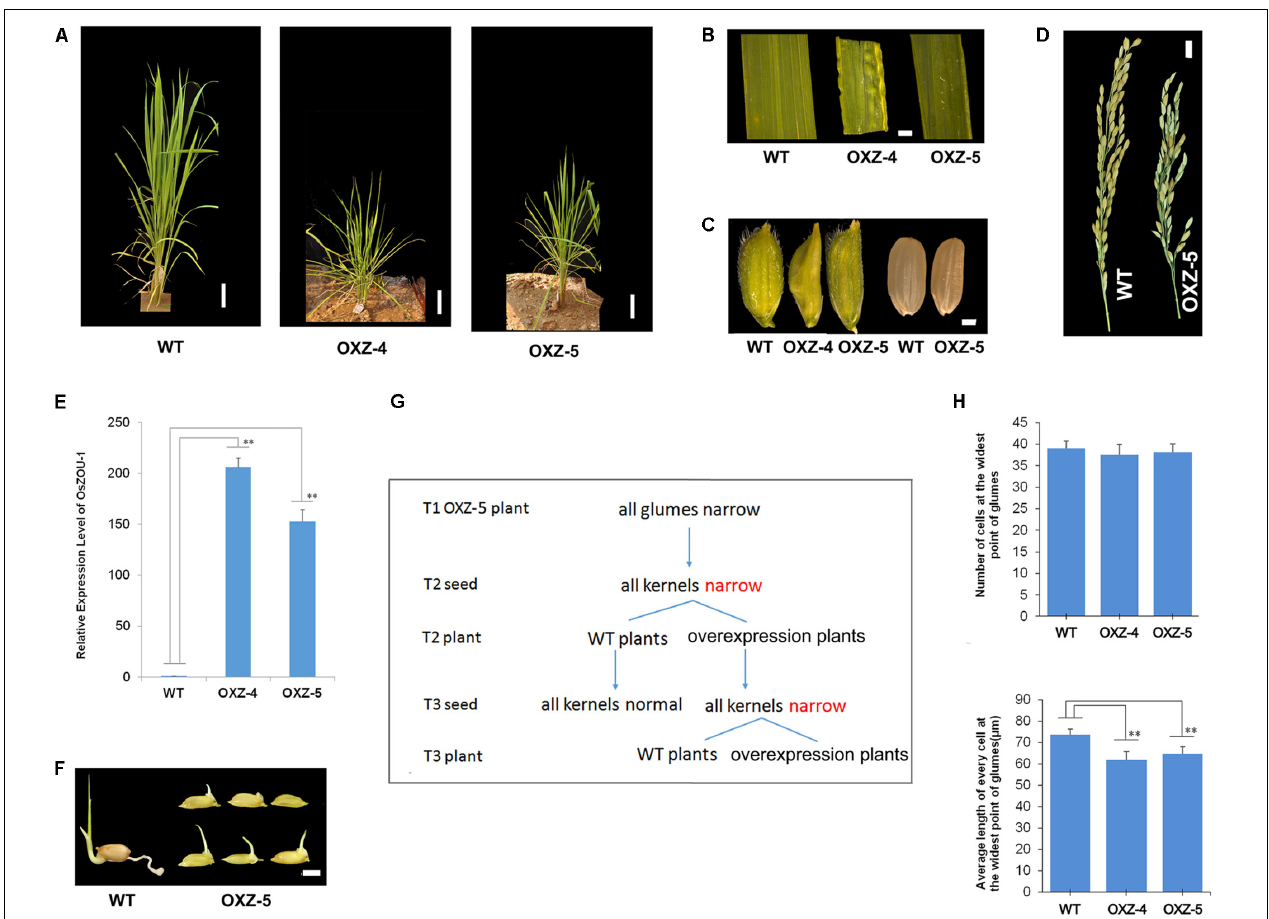
FIGURE 6 | The phenotype of OsZOU-1 over-expression lines. (A) The morphology of WT and OsZOU-1 over-expressed plants OXZ-5 and OXZ-4 in the jointing-booting stage were photographed. Scale bars = 8 cm. The OXZ-5 plant (54.48 cm) and OXZ-4 plant (47.52 cm) were shorter than the WT plant (81.28 cm). (B) The leaves of OXZ-5 and OXZ-4 curled upward along the leaf margin before booting and were narrow, while some leaves of OXZ-4 were uneven. Following booting, the upward curling leaf blade phenotype changed. (C) The glumes and kernels of OXZ-5 and OXZ-4 were narrower than WT. (D) Spikes of WT and OXZ-5 plant at the mature stage. Scale bar = 1 cm. The over-expression of OsZOU-1 led to reduced fertility. (E) The relative expression levels of OsZOU-1 in unopened flowers of WT and transgenic lines. OsActin1 was used as the internal control and the expression level of OsZOU-1 in unopened flowers of WT plant was set as 1. The expression levels of OsZOU-1 in unopened flowers of OXZ-4 and OXZ-5 were respectively 206 and 152 times higher than WT. Error bars correspond to the SDs calculated from four technical replicates on pools of eight unopened flowers from the WT, OXZ-4, or OXZ-5 plants, respectively. (F) The germination situation of WT and OXZ-5 seeds that were put in water six days previously. These results show that the germination of OXZ-5 seeds was difficult and inconsistent. Scale bar = 0.5 cm. (G) Heritability of the narrow kernel phenotype in OXZ-5 transgenic plants. (H) Cell numbers and lengths at the widest point of the glumes of WT and over-expressed plants. Results are means ± SD ( n = 10); Student’s t -test value: ∗∗ p <